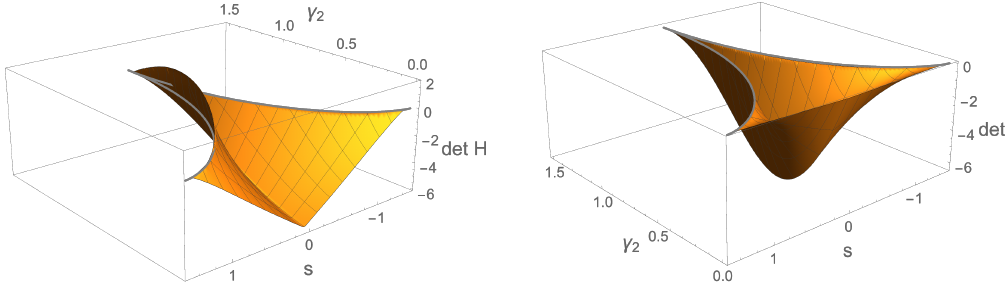
Figure 5 . The determinant of the Hessian, det H , as a function of s and γ 2 for γ 1 = 1 , M = 2 (left) and M = 3 (right). The variable s lies in the interval [ g ( e min ) / 2 , g ( − e min ) / 2] when the saddle point equation has three solutions. The grey curves show the boundaries of this interval. For M = 2